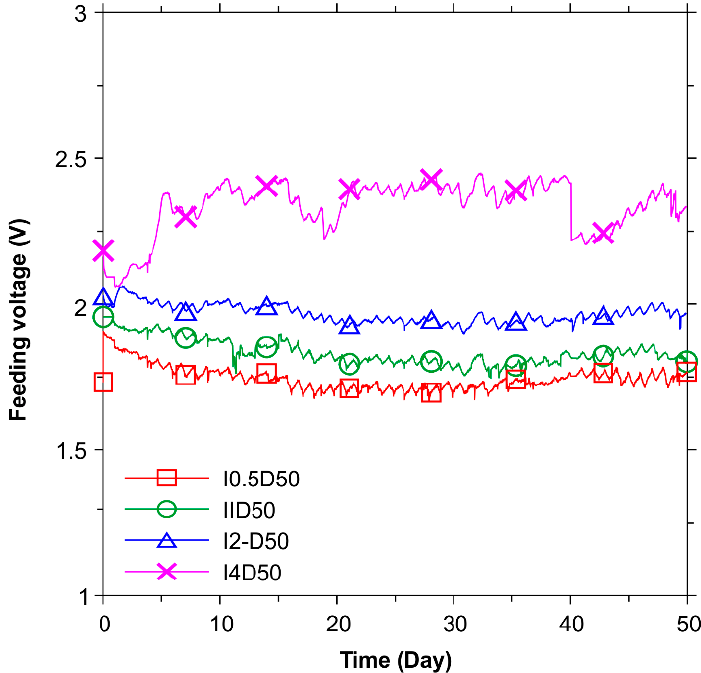
Figure 3. Results of feeding voltage with elapsed test time in the galvanostatic anodic polarization tests.